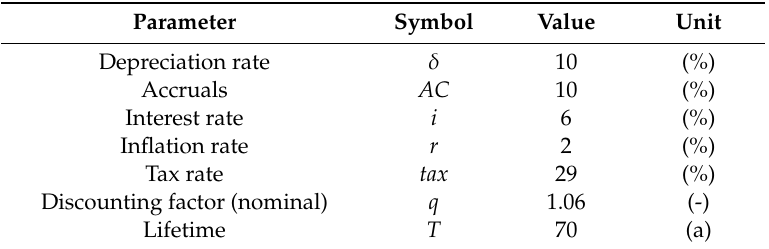
Table 6. Economic parameter values